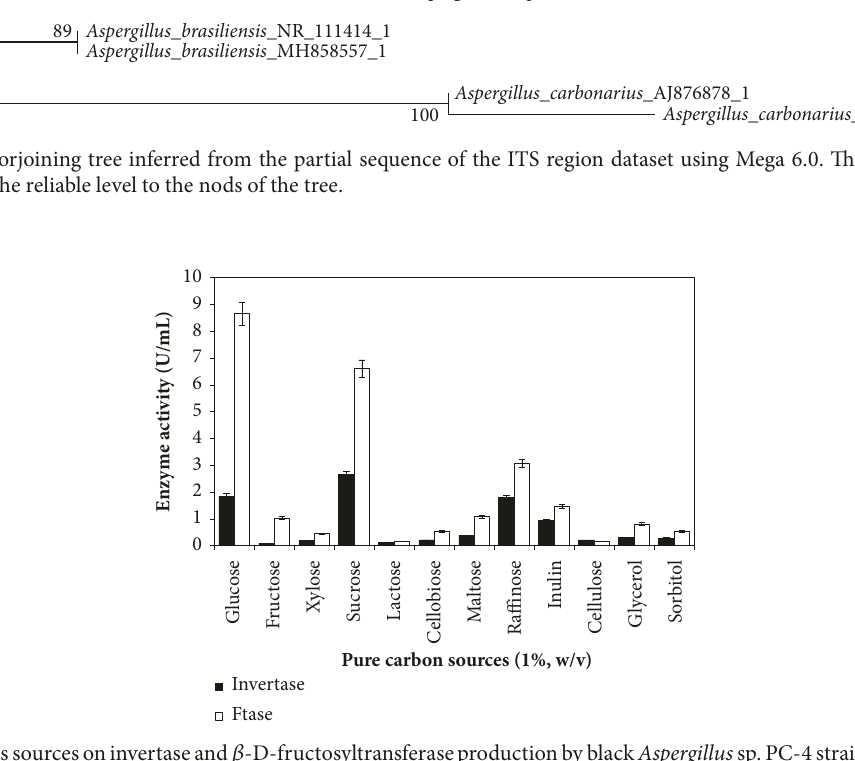
Figure 2:Purecarbons sourcesoninvertaseand 𝛽 -D-fructosyltransferaseproductionby black Aspergillus sp. PC-4strain.Cultureconditions: cultivation was carried out at 28 ∘ C, 180 rpm for 120